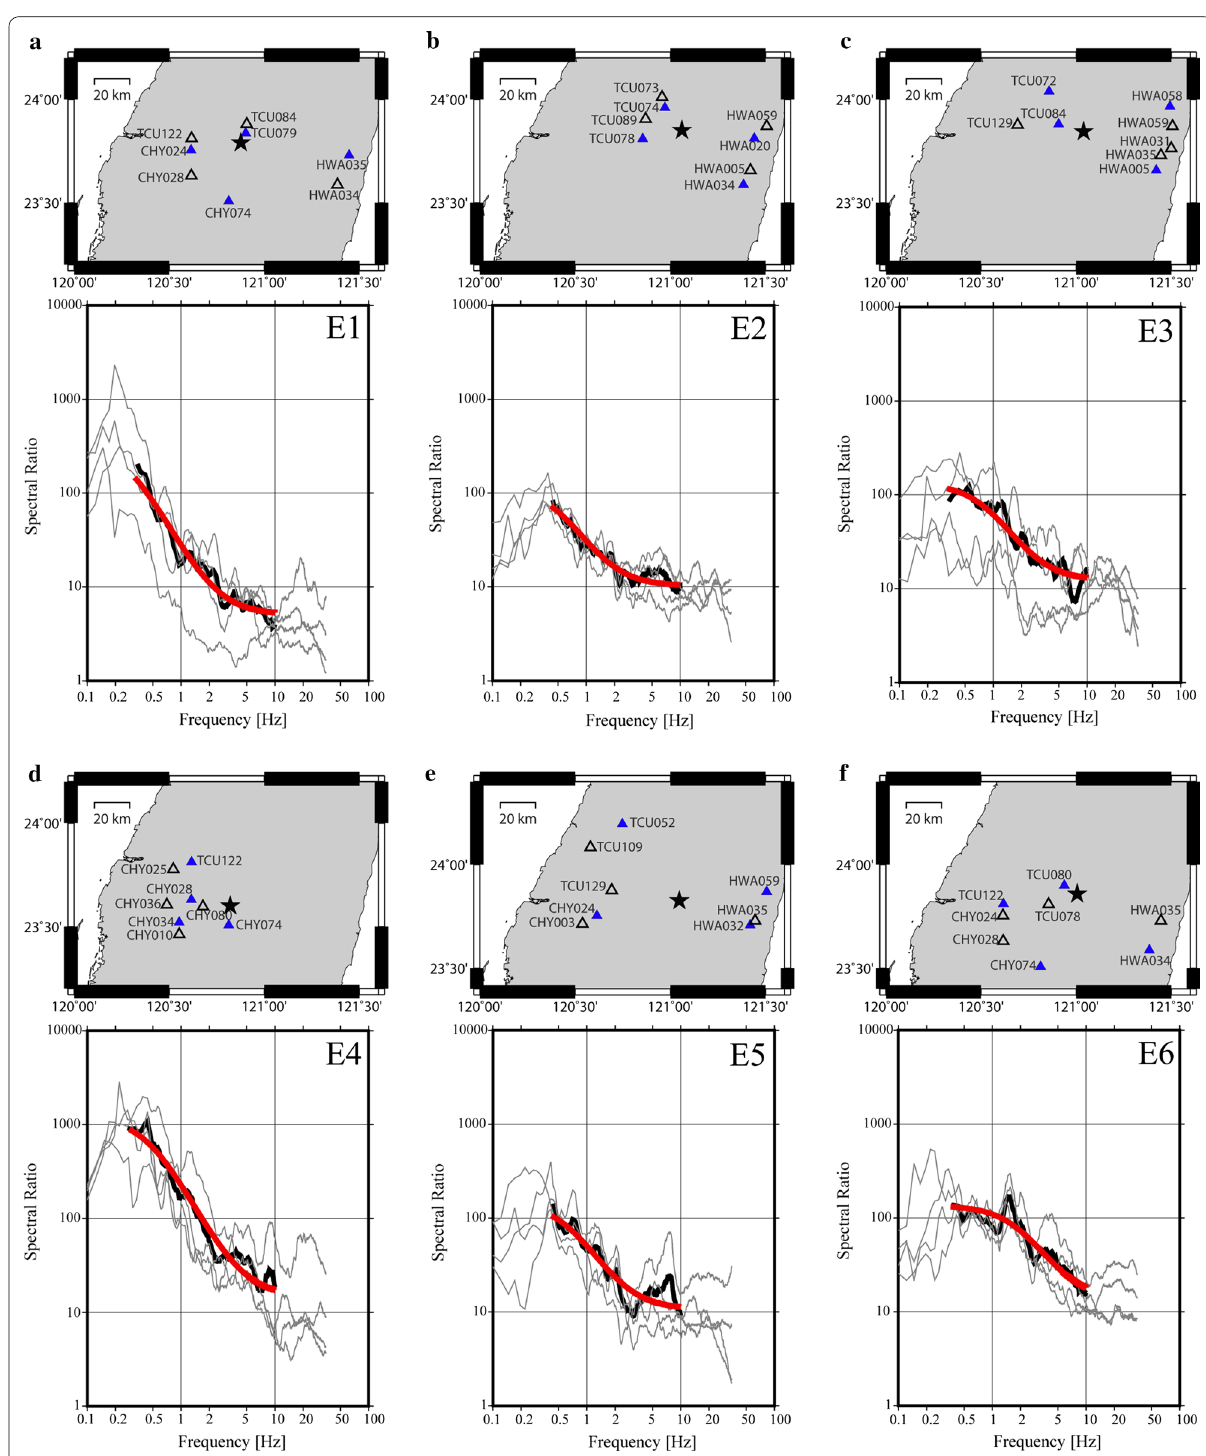
Fig. 2 Observed source spectral ratios of stations used for the source modeling (thin gray lines), the average observed source spectral ratios (thick black lines) and fitting source spectral ratio function (red lines) for a E1, b E2, c E3, d E4, e E5 and f E6 events, respectively. Solid and open triangles show stations used in the source spectral ratio analysis and forward EGF simulation for each event,